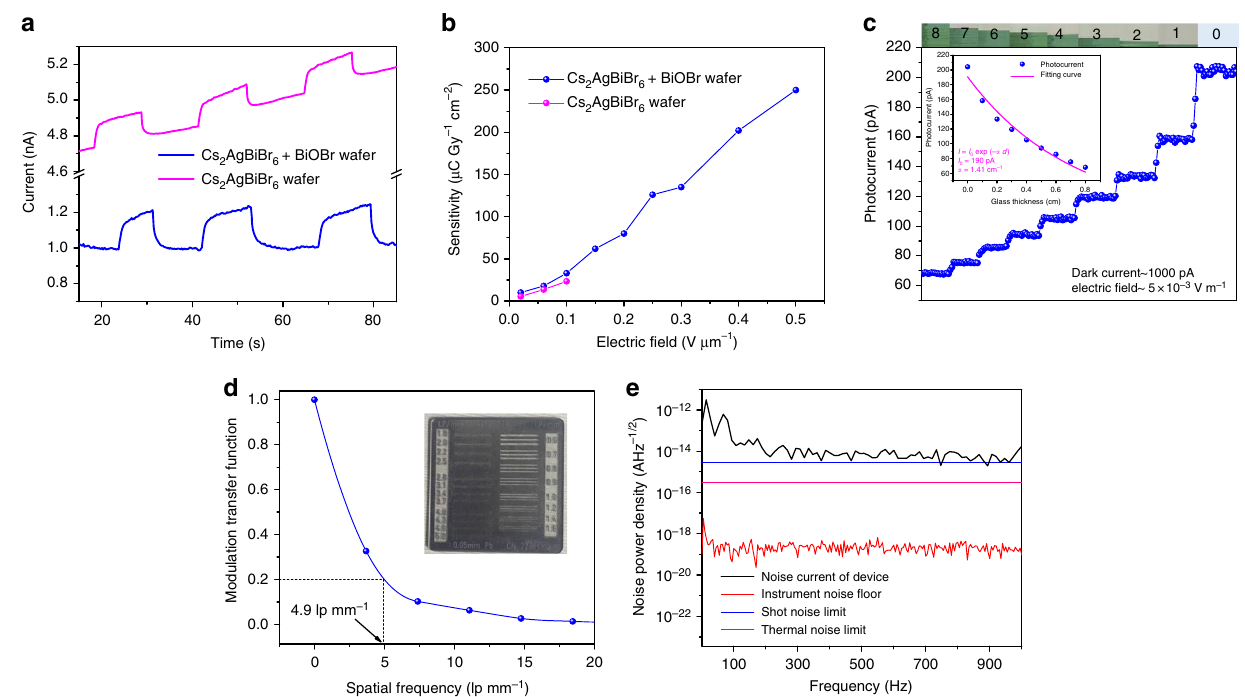
Fig. 4 Performance of Cs 2 AgBiBr 6 wafer X-ray detector. a Device response to X-rays (138.7 μ Gy air s − 1 ) under an electric fi eld of 0.1 V μ m − 1 . b X-ray sensitivity under different electric fi elds. c The response of the detectors toward stacked ITO glass coverslips. d Modulation transfer function for the fabricated detector and the inset is the line pair card for edge spread function measurement. e Measured dark current noise at various